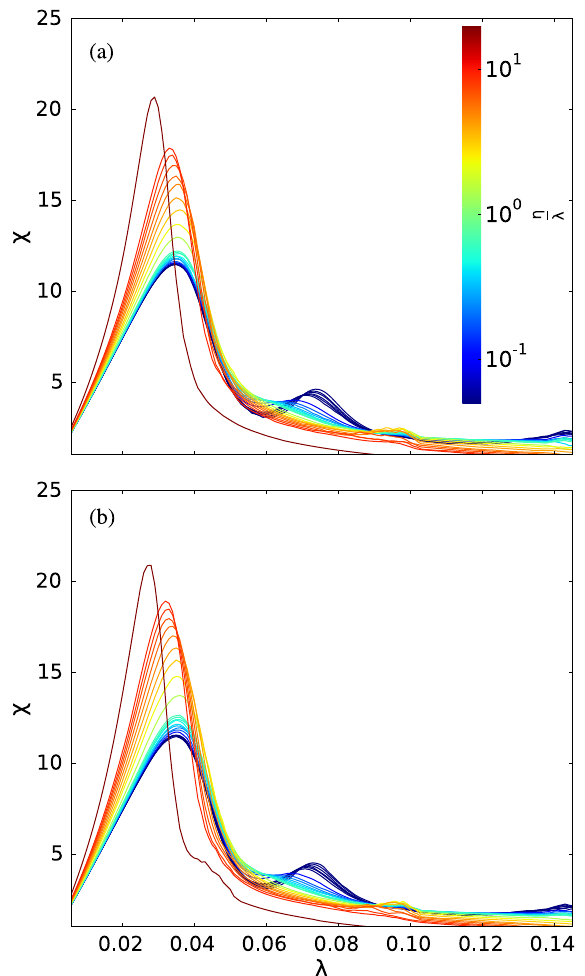
(2013).FIG. 18. Susceptibility χ as a function of λ considering all three-layer configurations and many different ratios η = λ , which is represented by the color of the lines. The recovering rate is μ ¼ 1 . The simulated values are ð η = λ Þ ¼ 0 . 05 , 0.06, 0.07, 0.08, 0.09, 0.1, 0.2, 0.3, 0.4, 0.5, 0.6, 0.7, 0.8, 0.9, 1.0, 2, 3, 4, 5, 6, 7, 8,